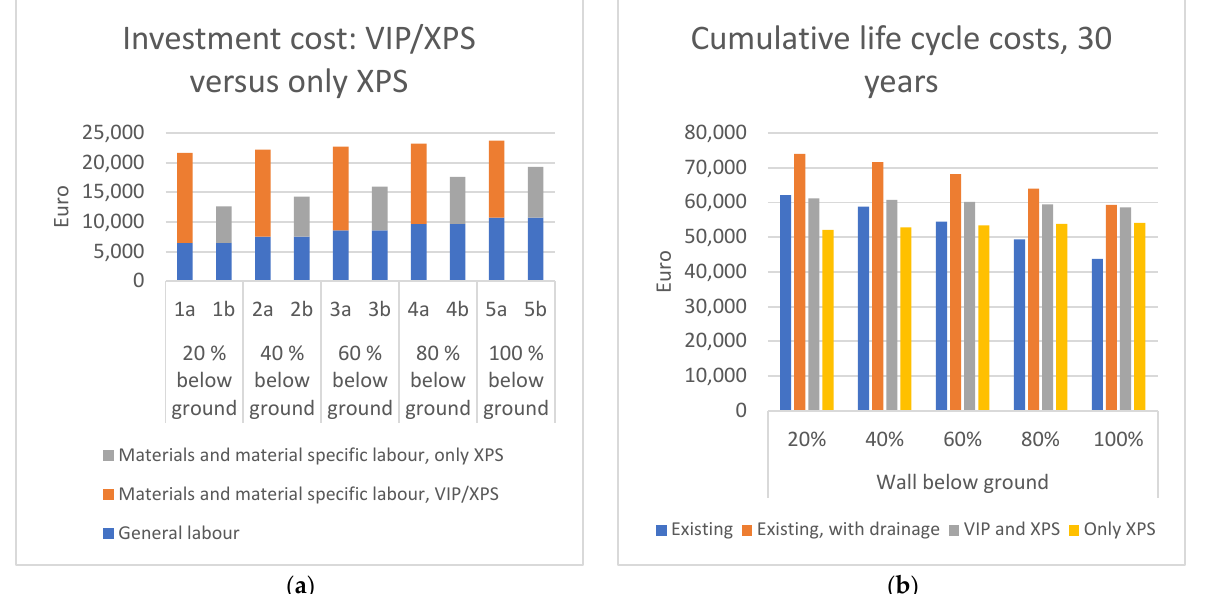
Figure 8. ( a ) The cost of upgrading with VIP and XPS versus upgrading with only XPS. Values in Eruo. Basement wall height is 240 cm, where 30 cm are always above ground. Percentages refer to how much of the remaining 210 cm are below the ground; ( b ) the cumulative life cycle cost for four alternatives (no upgrade, only drainage, upgrade with VIP and XPS, and upgrade with only XPS). Values in Euro.